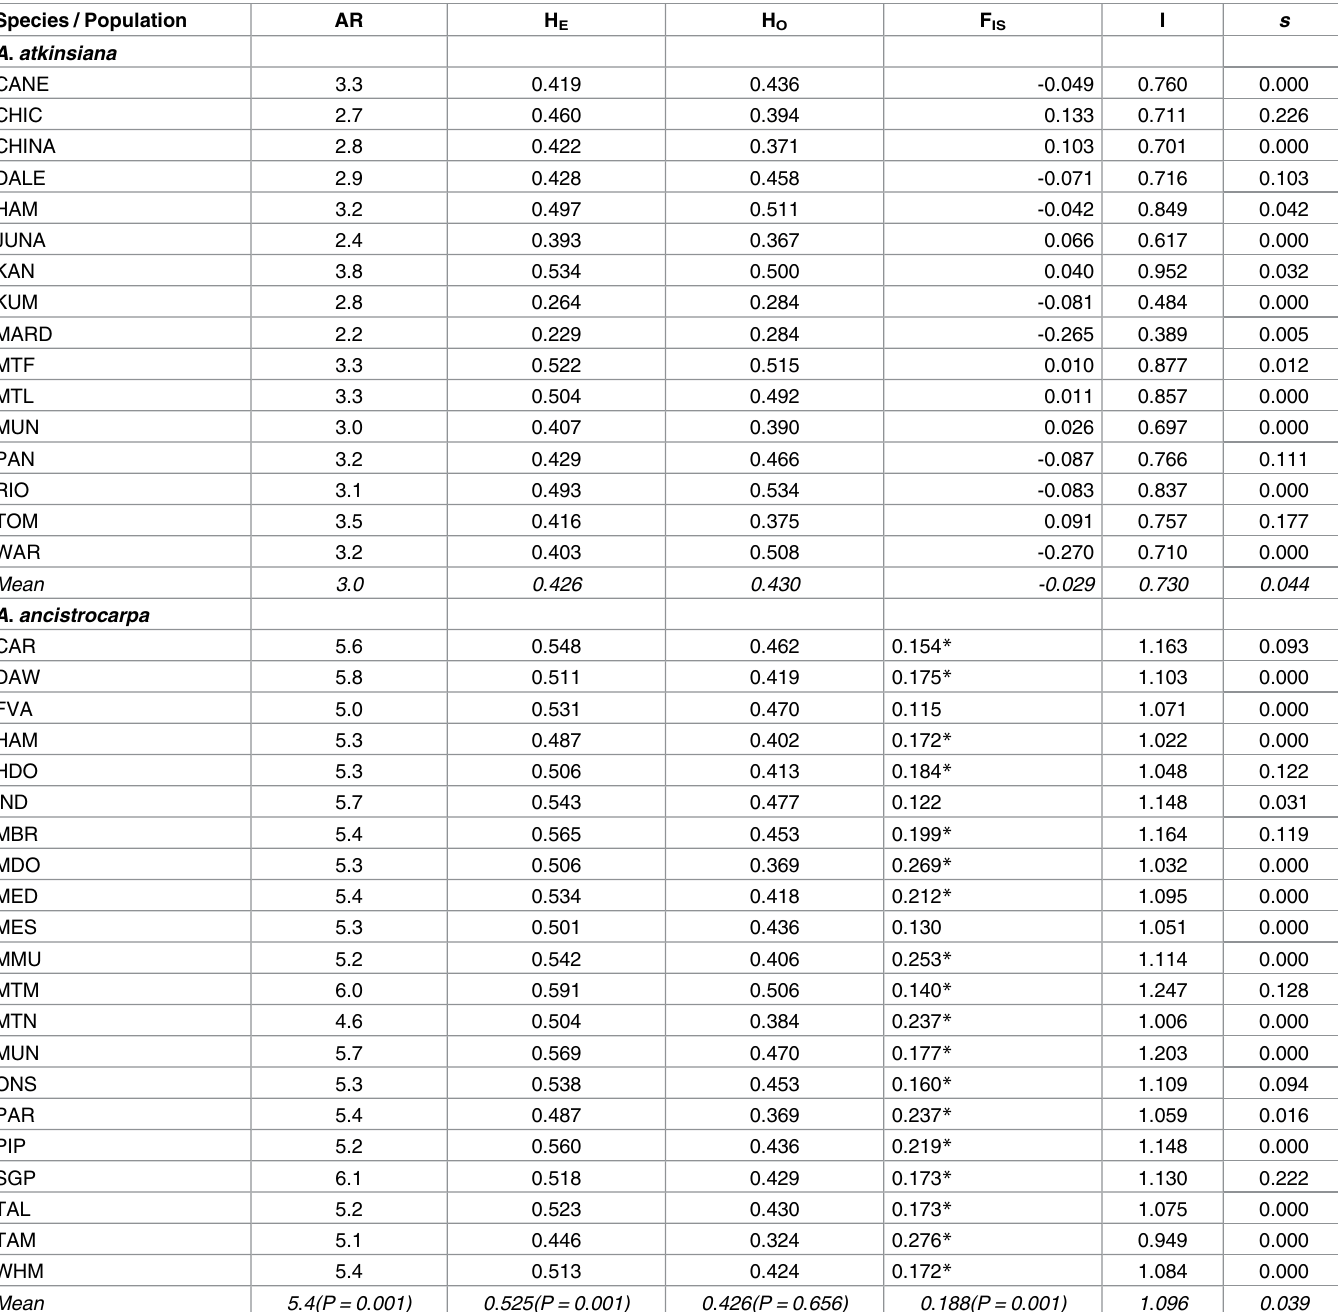
Table 1. Nuclear genetic diversity characteristics of Acacia atkinsiana and A . ancistrocarpa populations. Allelic richness (AR), observed heterozy- gosity (H O ), expected heterozygosity (H E ), inbreedingcoefficients (F IS ) and Shannondiversity indices (I) are means across all loci. Significant departures from HWE are indicatedby an asterisk. Selfing rates( s ) obtained using the robust multilocus method. P values relate to differences between species for each